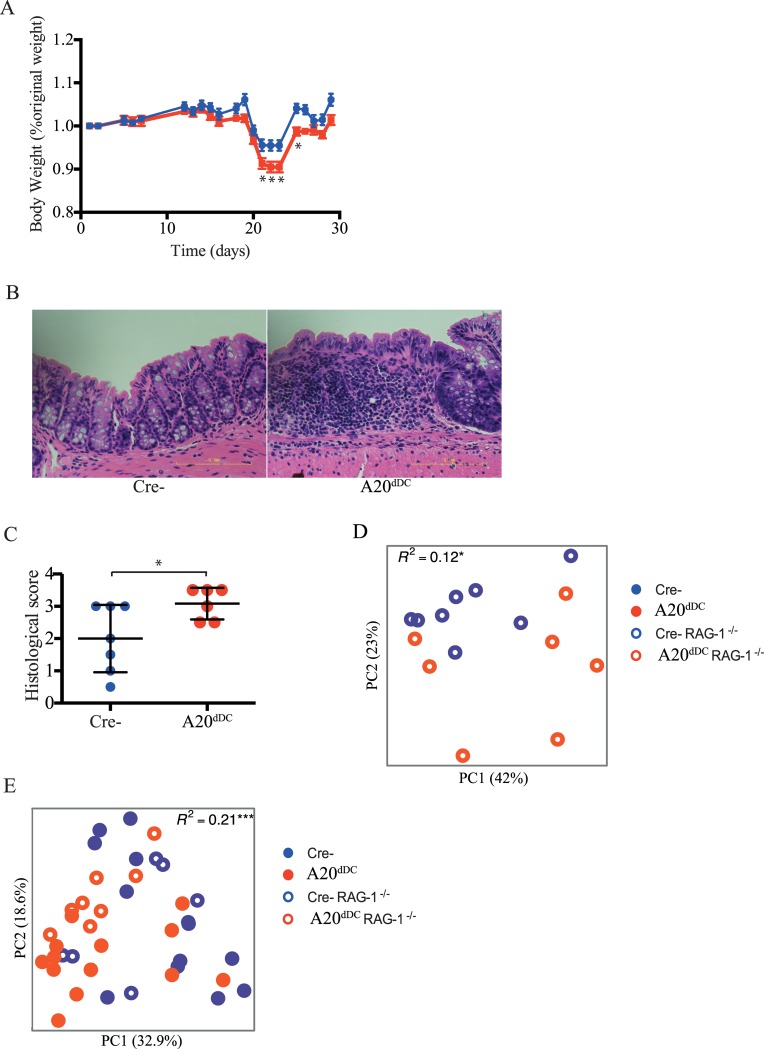
Dysbiotic microbes from A20Fl/Fl CD11c-Cre mice confer susceptibility to intestinal inflammation.(A) Body weights of C57BL/6J wild type (WT) mice that received fecal microbiota transfer from either A20dDC mice (red, n = 8) or A20FL/FL (Cre-) control mice (blue, n = 8) and were subsequently treated with DSS for 5 days. (B) Representative images of H&E stained colonic tissues from mice in (A). Original magnification x 40. (C) Histological scores from colonic tissues shown in (A and B) (n = 6 mice per group). Data are representative of two independent experiments. (D) β-diversity analyses of fecal microbiota communities from intact 6 month-old A20dDC RAG-1-/- mice (red open circles, n = 7) and control A20FL/FL (Cre-) RAG-1-/- mice (blue open circles, n = 8 mice); * = p <0.05. (E) β-diversity analyses of fecal microbiota from A20dDC mice (filled red circles, n = 13), A20FL/FL (Cre-) mice (filled blue circles, n = 13), A20dDC mice RAG-1-/- (open red circles, n = 6), and A20FL/FL (Cre-) RAG-1-/- mice (open blue circles, n = 8) *** = p <0.001.